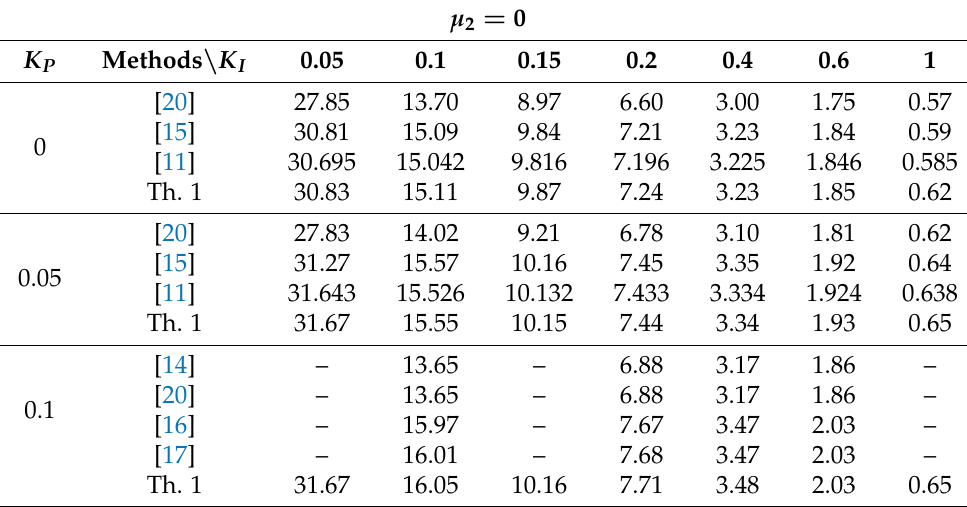
Table 9. MAUBs h 2 for h 1 ( t ) = 0 and µ 2 = 0.5 under two-area LFC system.